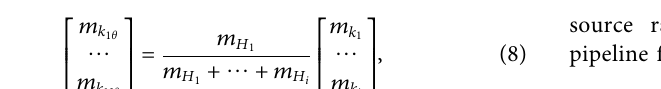
Frontiers in Energy Research |